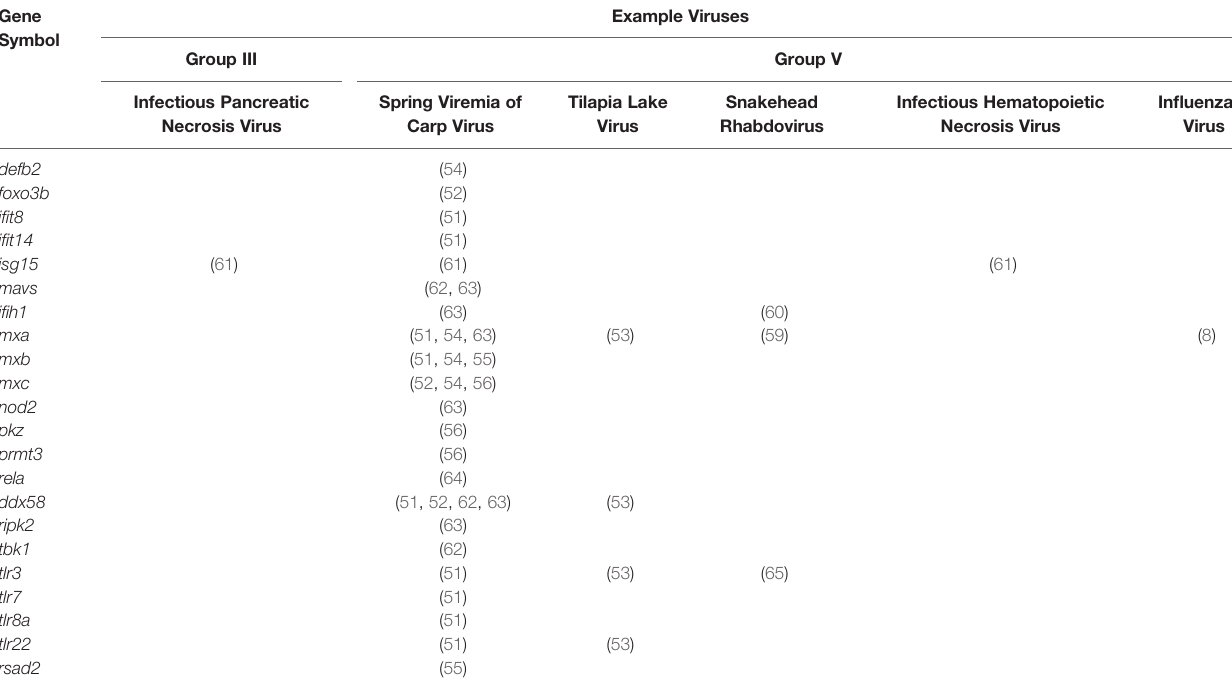
Example Viruses